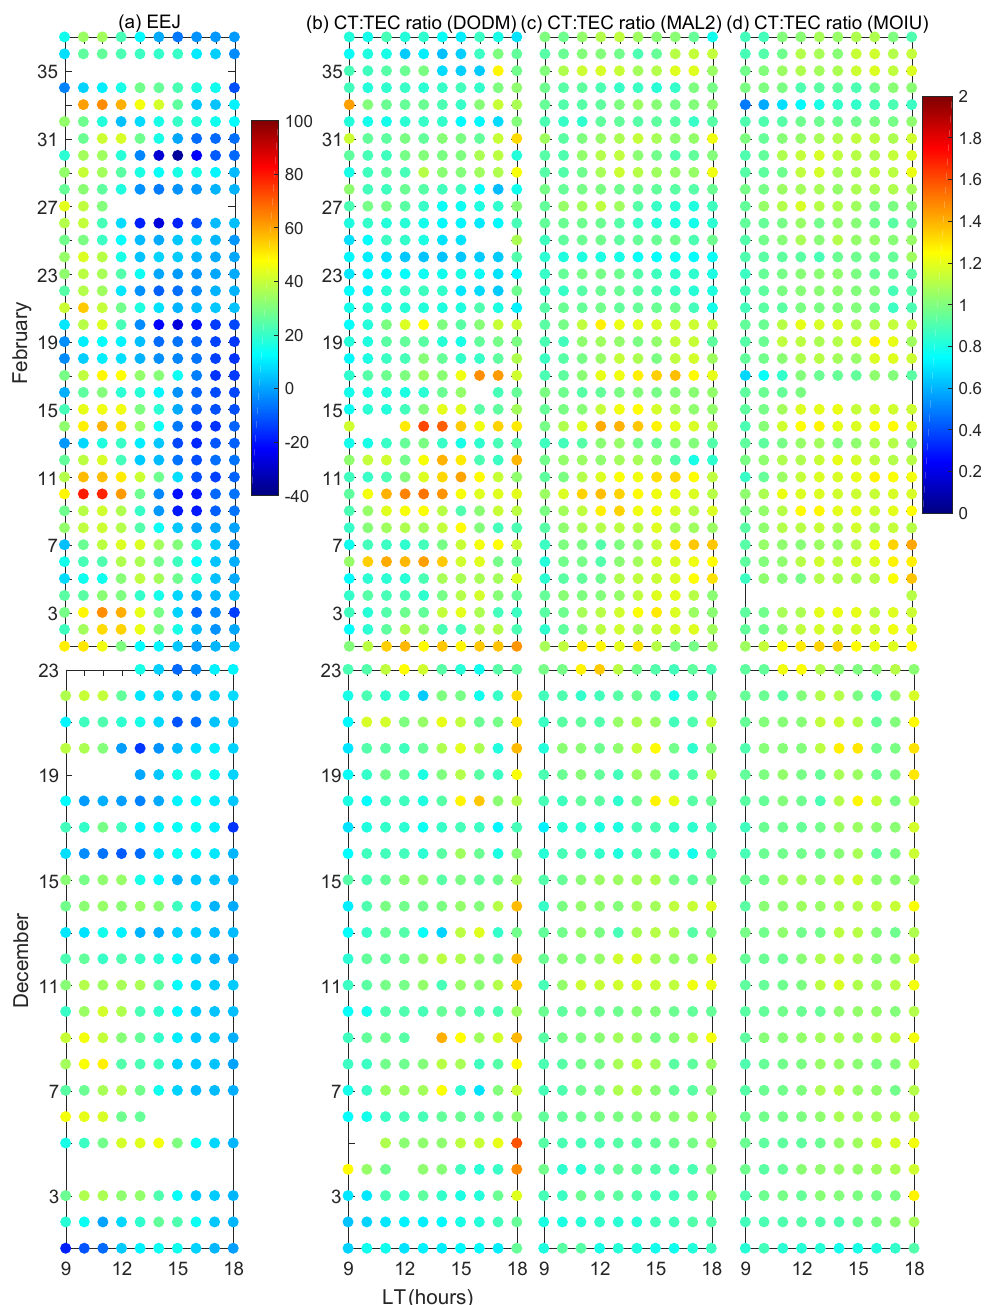
Figure 5. A zoom-in of Fig. 4 for the months of February and December.